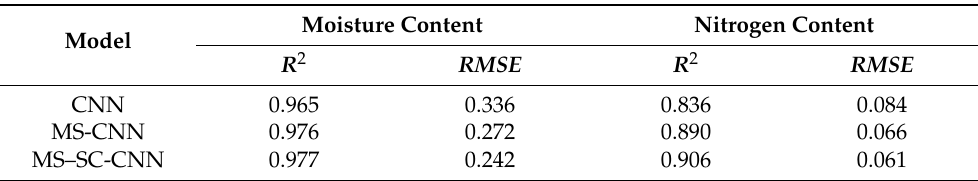
Table 3. Results of moisture and nitrogen content in Pinus massoniana seeding leaves using different convolutional neural network